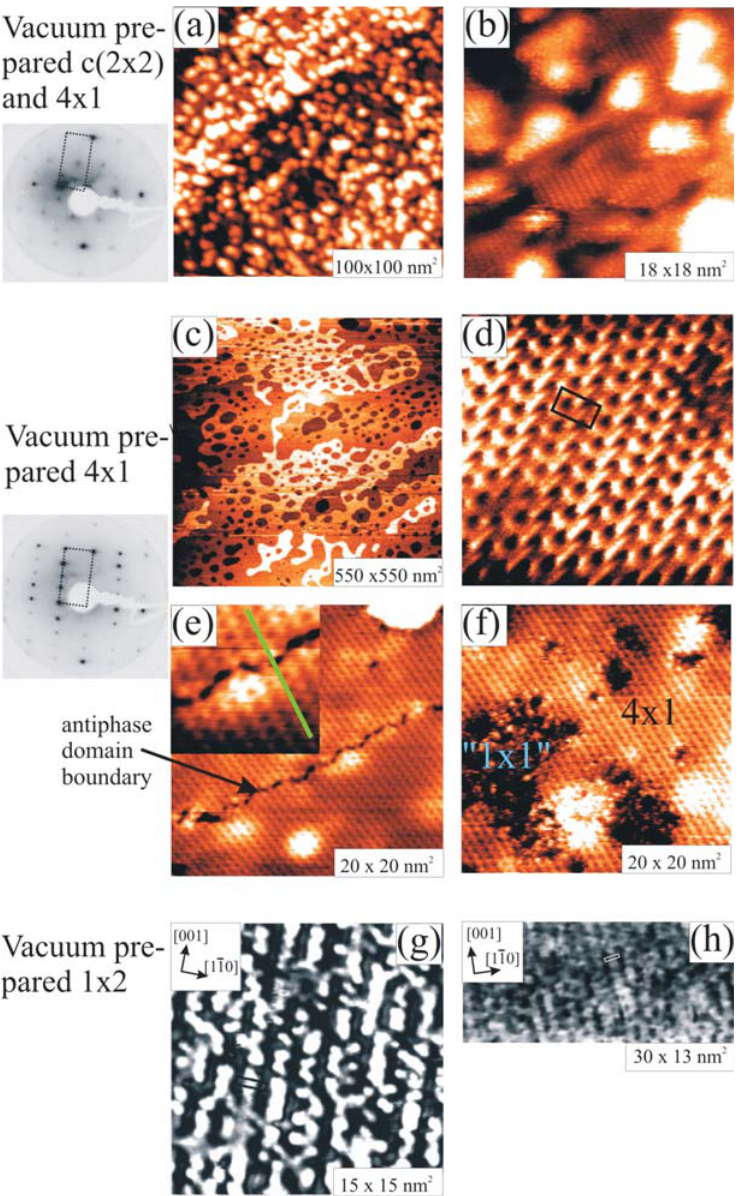
Figure 3 . Overview of surface structures obtained for the SnO (110) surface for different annealing 2 temperatures in UHV after ion sputtering. LEED patterns and STM images are shown. The 1x1 unit cell is indicated in the LEED patterns. (a) and (b) show STM images for low annealing temperatures surfaces are characterized by a coexistence of 4x1 and c(2x2) domains. The surface exhibits a high density of monolayer high islands that presumably are the c(2x2) domains while the “substrate” exhibits mainly 4x1 domains. (c) –(f) show 4x1 reconstructed surfaces. In (f) domains of disordered structure appear. (g) and (h) show 1x2 reconstructed surfaces obtained after high temperature annealing (note that (g) is an AFM image). (reproduced with permission from ref. [29], ref. [25], and ref.